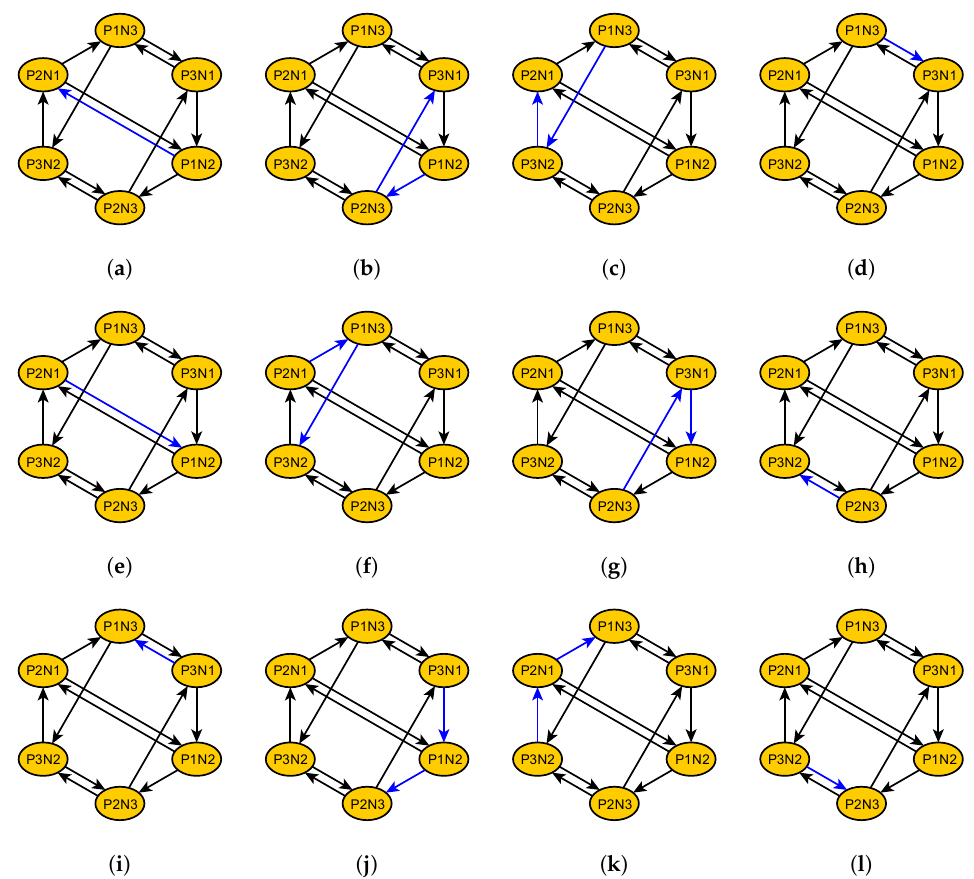
Figure 7. Desired paths ( a – l ) to define capacitors’